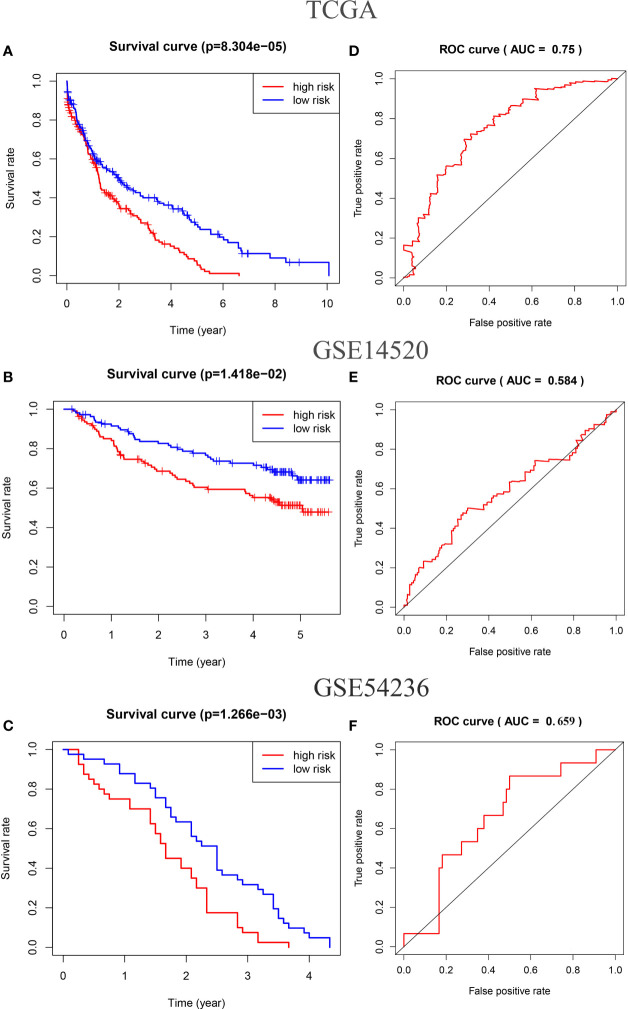
Kaplan–Meier analysis of the high-risk and low-risk groups of HCC samples in the TCGA (A), GSE14520 (B), and GSE54236 datasets (C). The receiver operating characteristic (ROC) curves of the risk score of HCC samples in the TCGA (D), GSE14520 (E), and GSE54236 datasets (F).